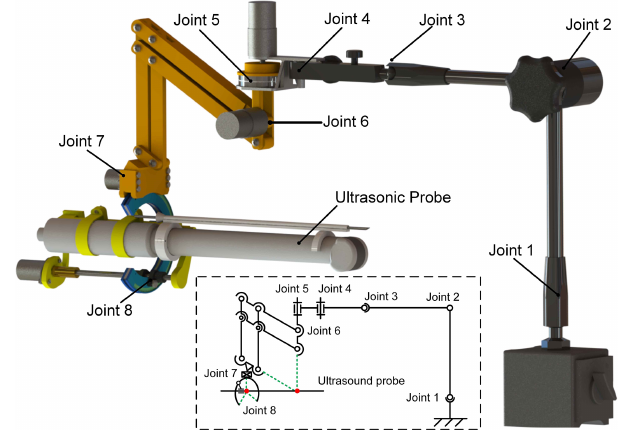
Figure 7. Schematic diagram of the overall